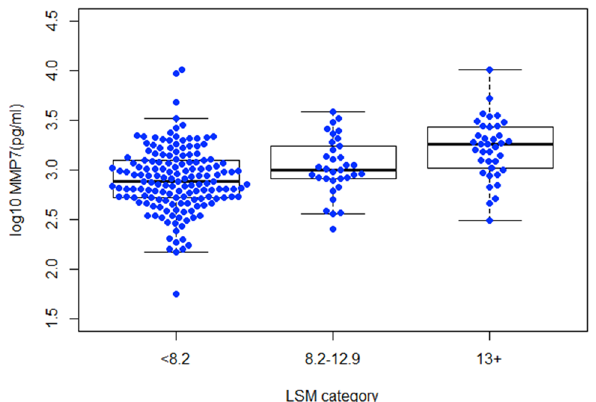
Figure 1. Association between serum MMP7 and LSM. Log serum MMP7 levels in patients with LSM indicative of no significant fibrosis (< 8.2), significant fibrosis (8.2–12.9) and cirrhosis (≥ 13) are shown using box plots with individual points. Upper and lower lines represent 1.5 IQR of the upper and lower quantile, middle line represents median and box represents 25th–75th percentile.